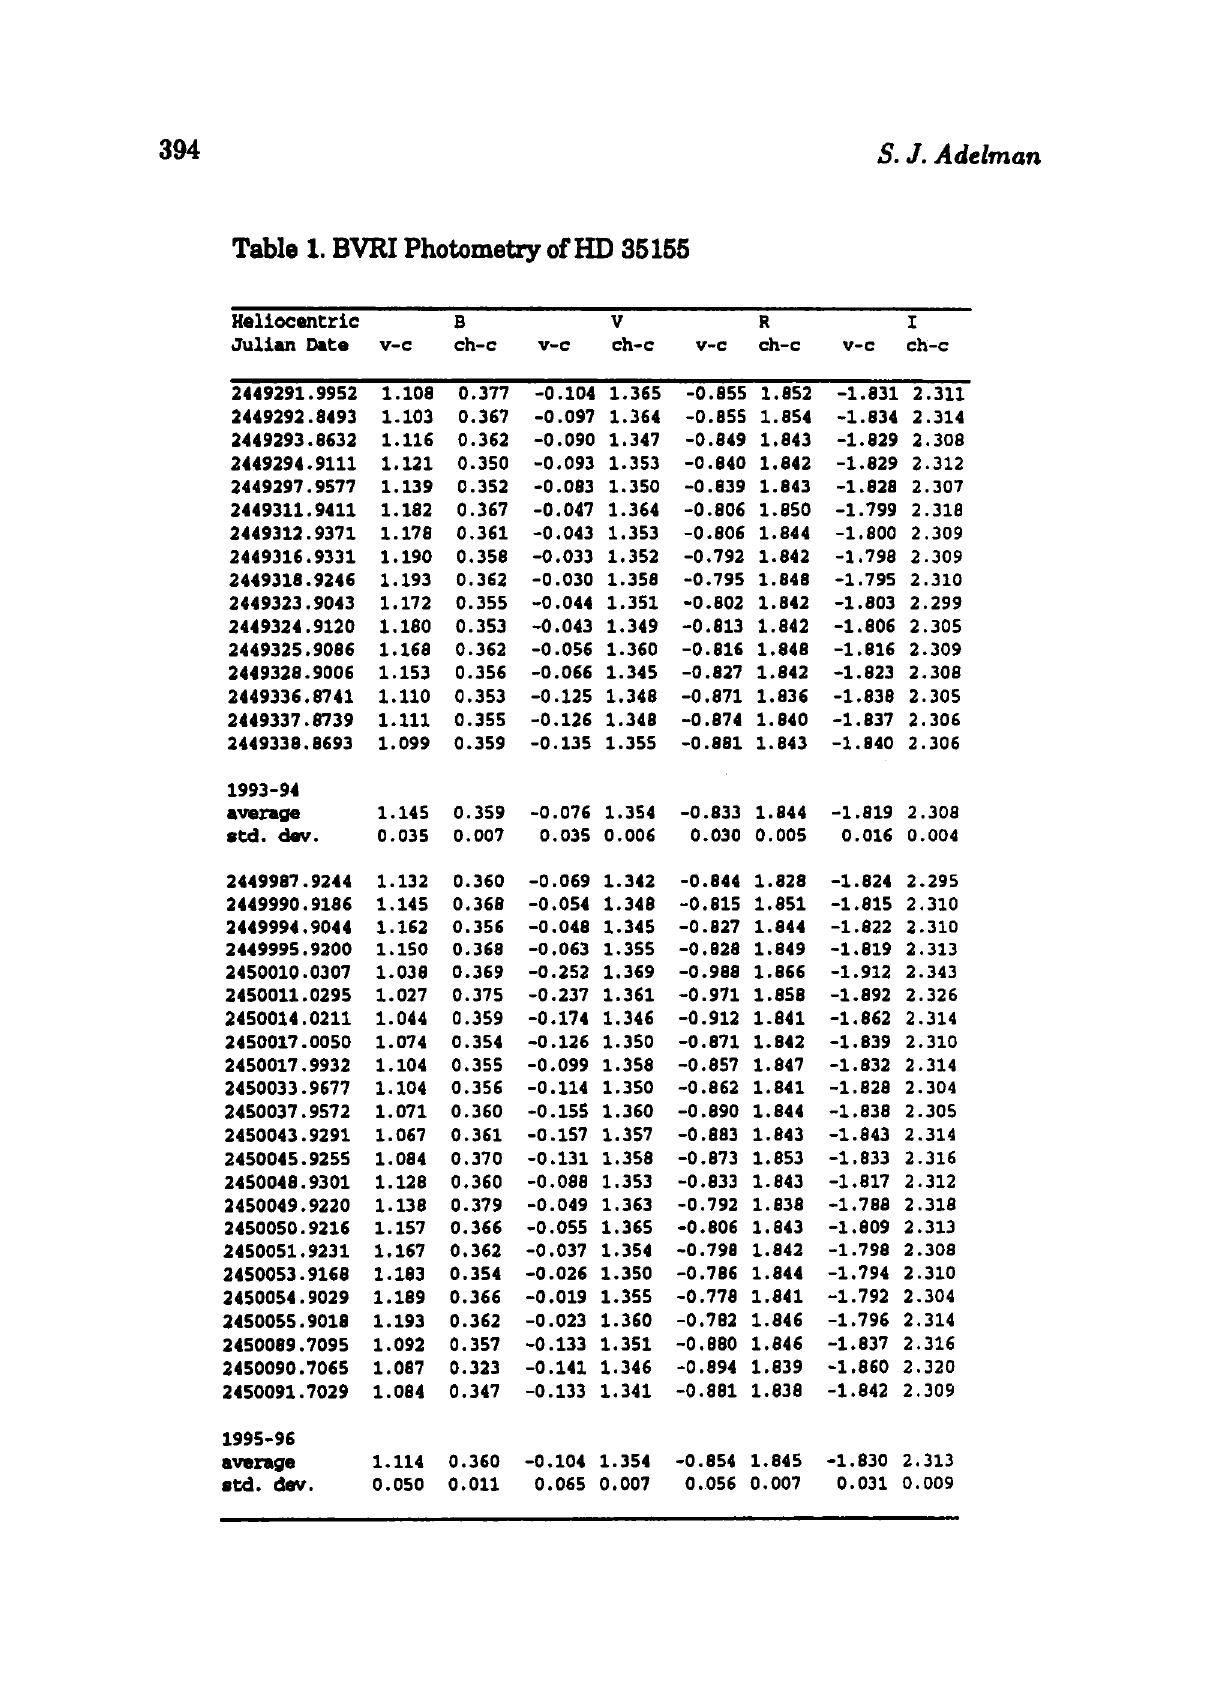
Table 1. BVRI Photometry of HD